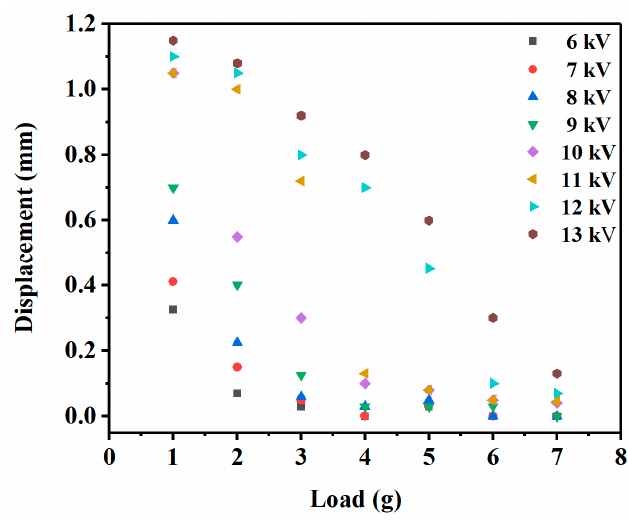
Figure 8. The stable output displacement of the actuator under loads from 1 g to 7 g and square wave voltages from 6 kV to 13 kV (20 Hz).